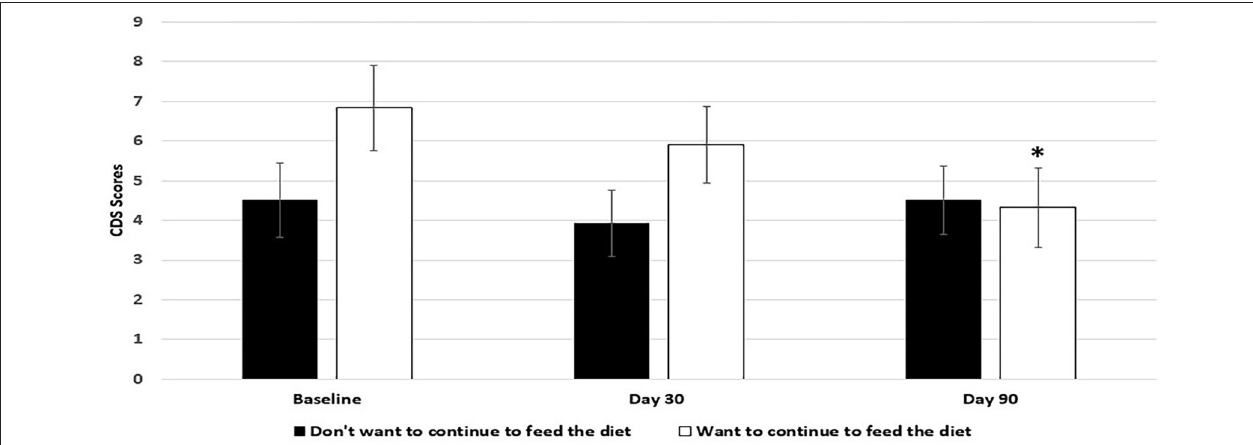
FIGURE 3 | Effects of owners’ comments on 9% MCT diet on the outcome of the diet. Twenty-nine client owned dogs were assessed for six different behavioral signs of cognitive dysfunction syndrome (CDS) and then placed on the 9% MCT diet. The dogs were re-assessed after 30 days and again after 90 days. The bars illustrate Means ± SEM for the mean score of six different behavioral signs at baseline, 30 days and 90 days. Six dogs dropped out of the study. Out of the 23 dogs remaining at the end of the study, 12 dog owners answered that they do not want to continue to feed their dogs with the diet, and 9 dog owners answered that they want to continue to feed their dogs with the diet. Fisher LSD test was used to analyze the data between the baseline and day 30 or baseline and day 90. The asterisks indicate statistically significant differences ( p < 0.05) from baseline.